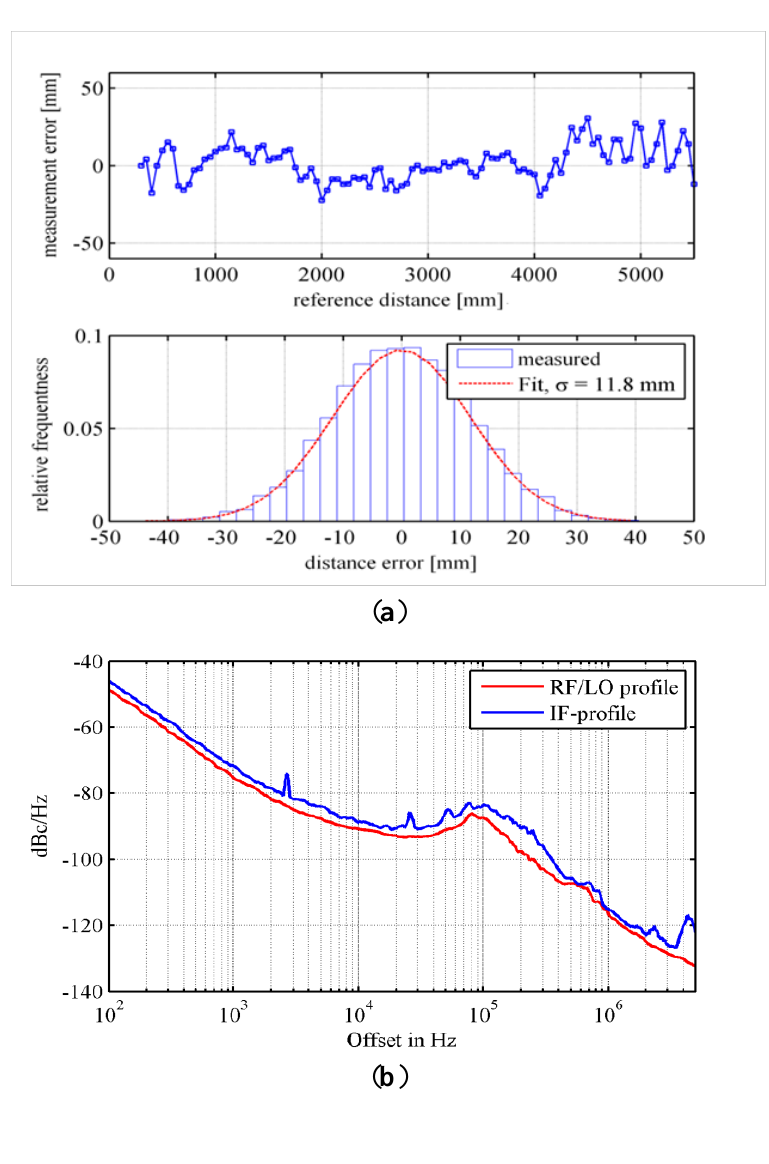
Figure 12. ( a ) Distance accuracy and ( b ) phase noise of the second generation 24 GHz